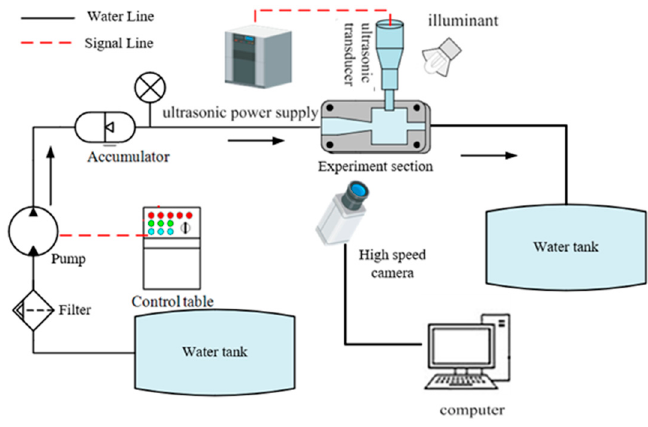
Figure 1. Experimental setup schematic.